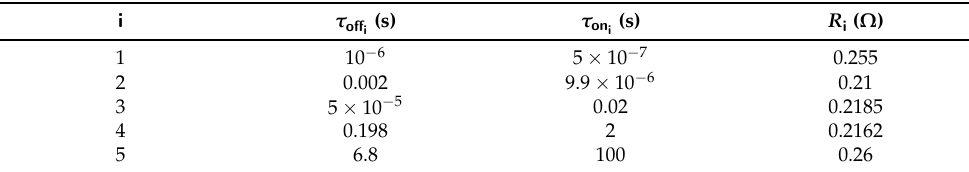
Figure 10. Comparison between analytical model and measurement on GaN device dynamic R DSon value under single pulse measurement: ( a ) Under different t off . ( b ) Under different t off and t on . Table 5. Different parameters used in the